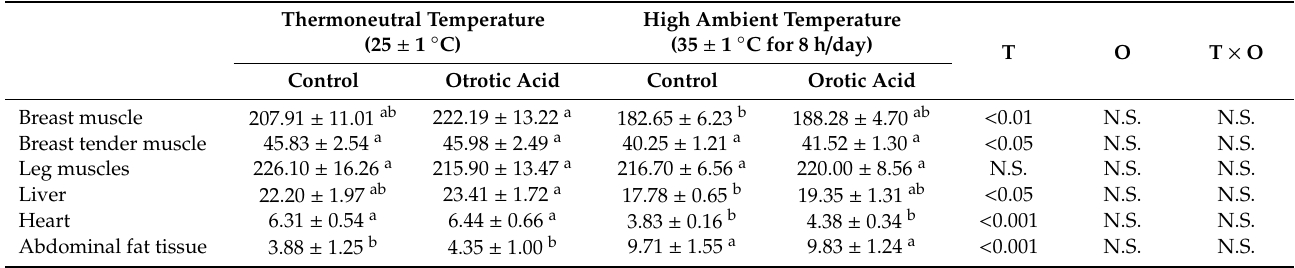
Table 2. E ff ects of a cyclic high ambient temperature and feeding orotic acid on the weights of tissues of broiler chickens (g).